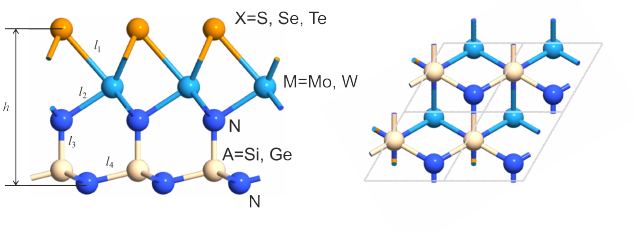
Figure 1. Geometry of the XMAN 2 monolayer. Lattice parameter, bond lengths, and thickness are listed in Table 1. Table 1. Lattice parameter a , bond lengths l 1 , l 2 , l 3 , l 4 and thickness h of optimized Janus